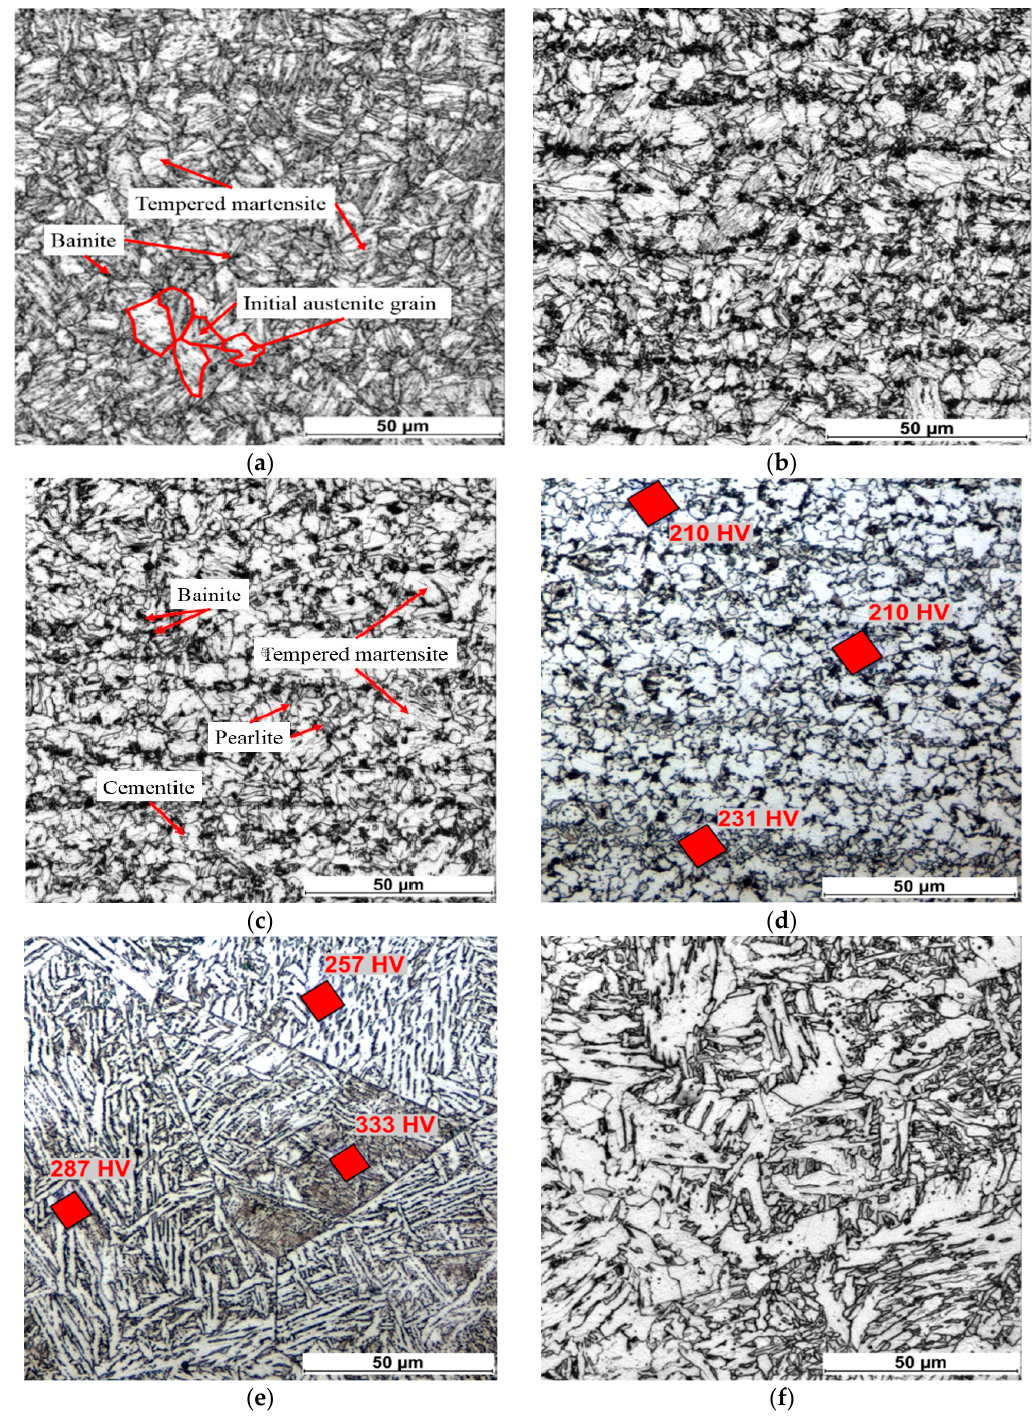
Figure 8. The optical microstructure of the quenched and tempered (QT) steel welded joint (second welding condition): ( a ) base metal; ( b ) subcritical heat-affected zone (SCHAZ); ( c ) inter-critical HAZ (ICHAZ); ( d ) fine-grain HAZ (FGHAZ); ( e ) coarse-grain HAZ (CGHAZ); ( f ) weld interface.